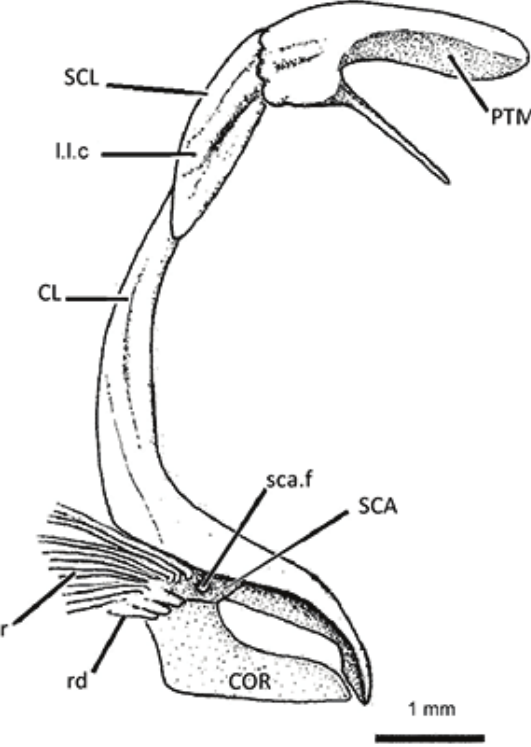
Figure 7 . † Scutatuspinosus itapagipensis Santos and Corrêa 1985: pectoral girdle and fin of DGM